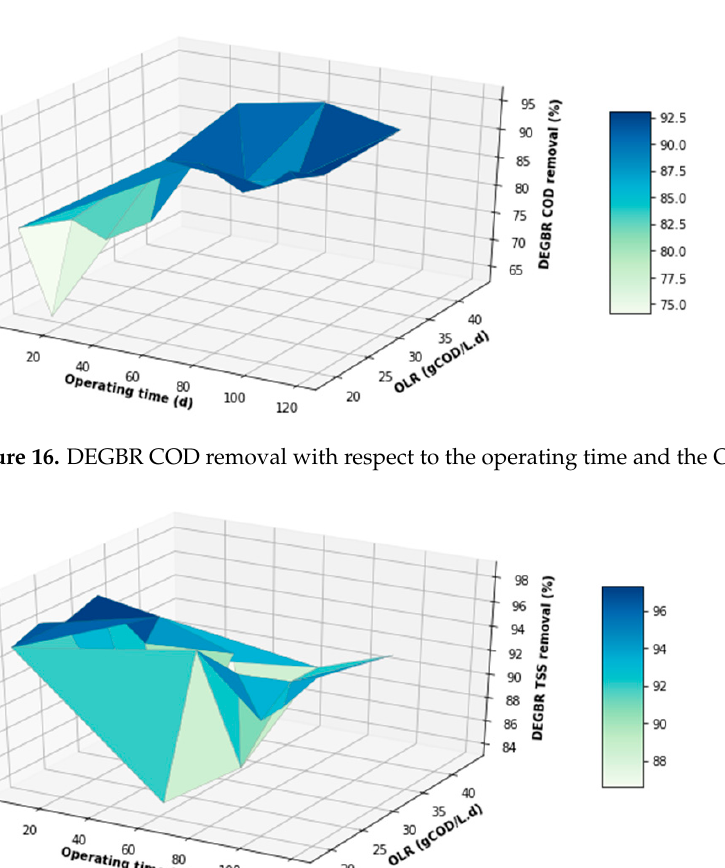
Figure 15. DEGBR FOG removal with respect to the operating time and the OLR.